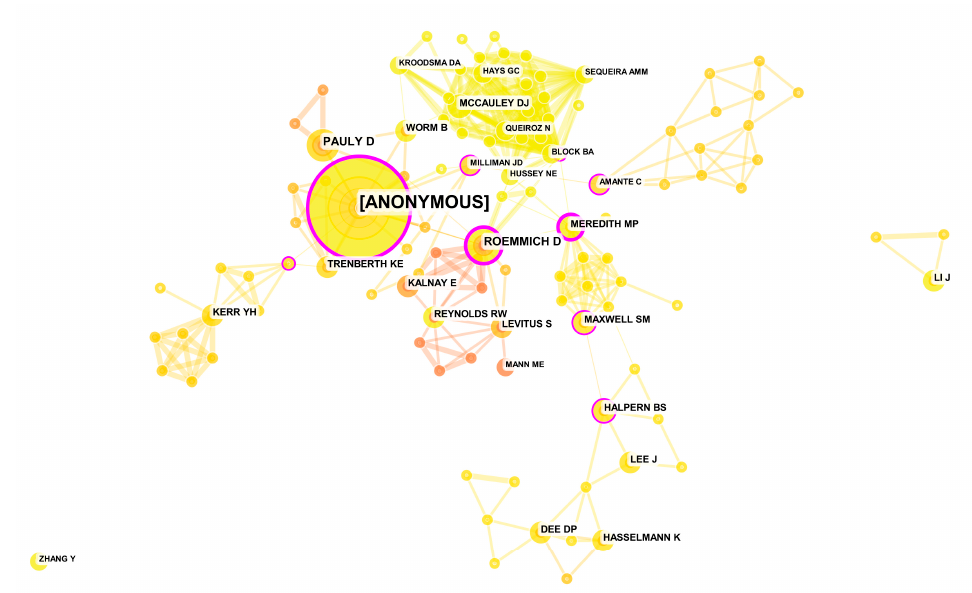
Figure 7. Author co-citation network map. Table 5. Top 10 most cited authors of big ocean data documents.